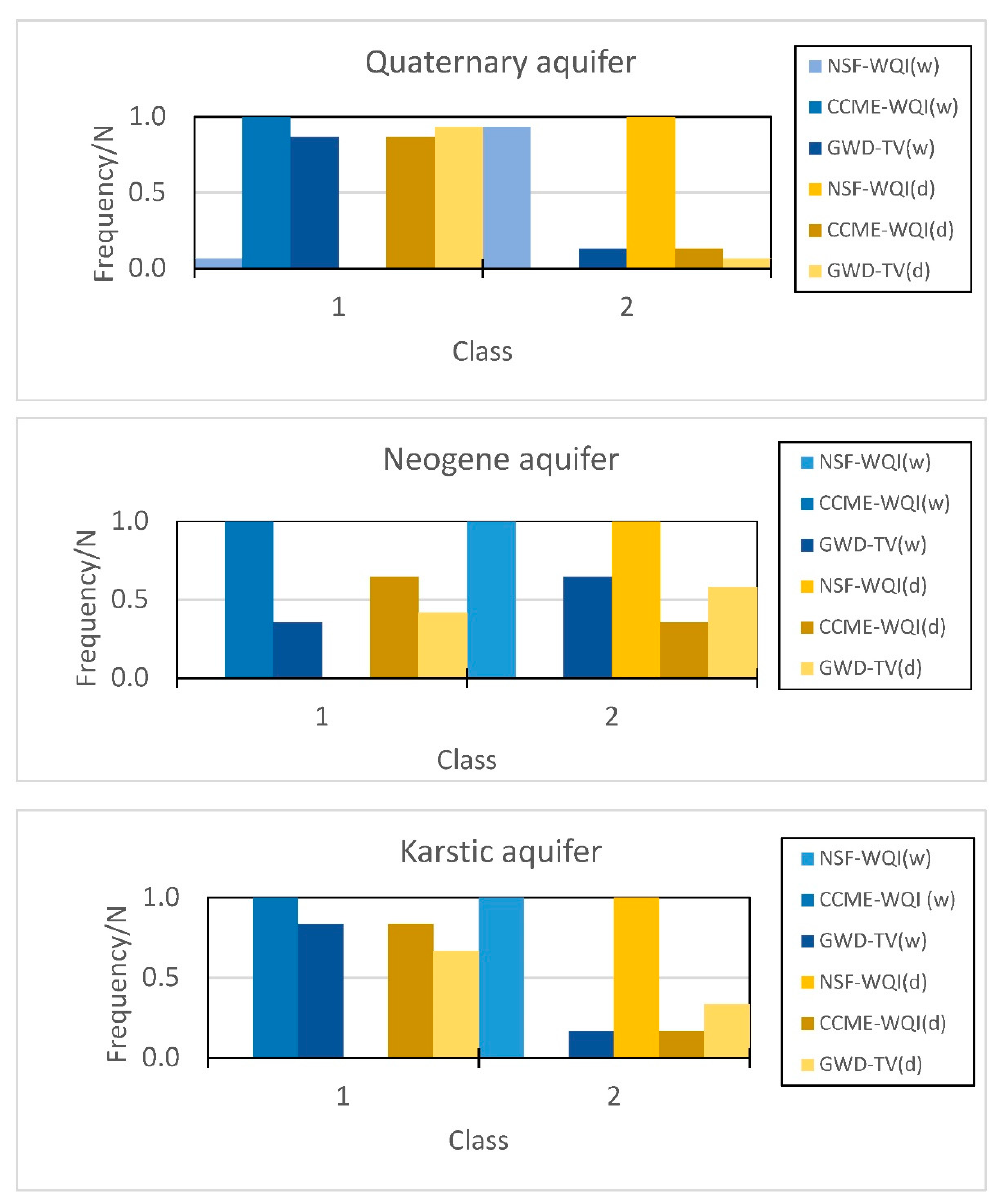
Figure 5. Normalized frequency diagrams for classes in groundwater monitoring stations of the area studied.